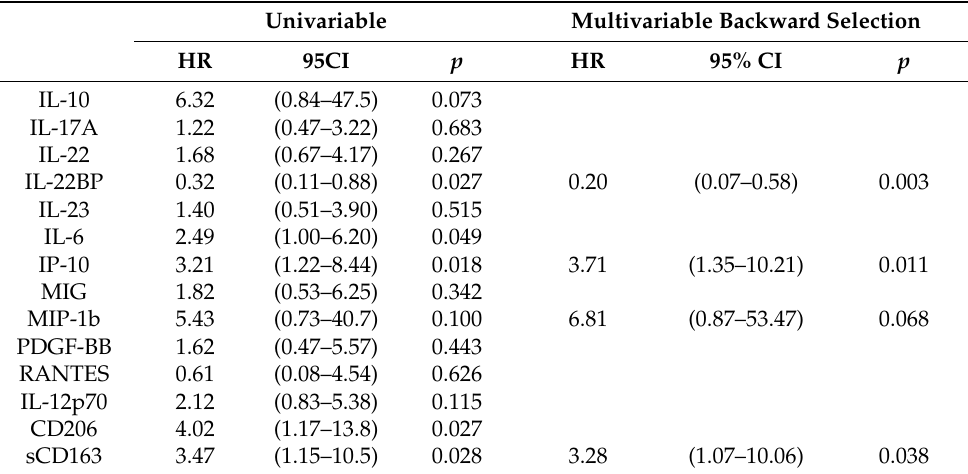
Table 3. Univariable and multivariable analyses of categorical cytokine risk factors for predicting DILI development in TB patients.